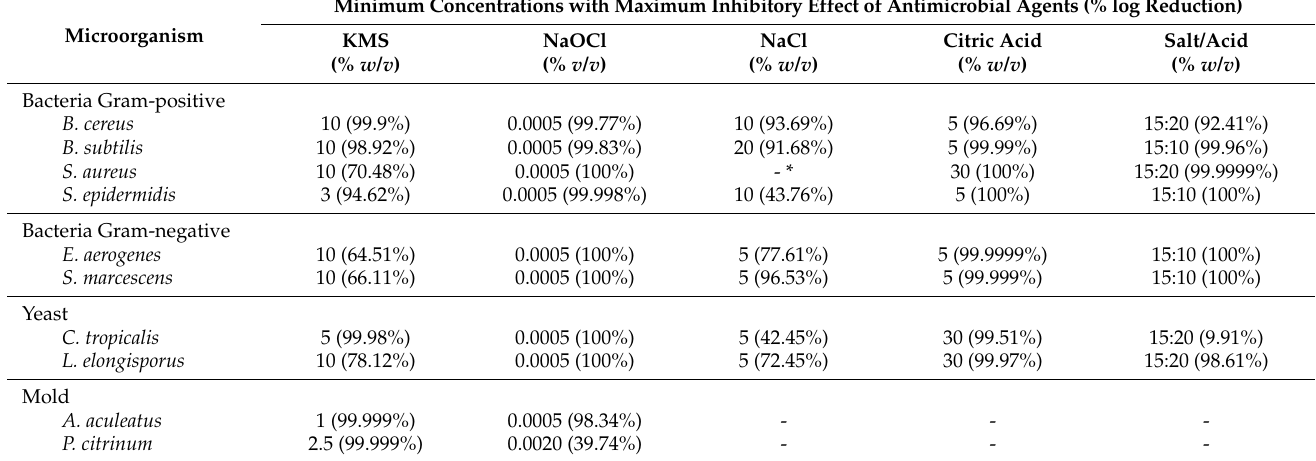
Table 2. Efficacy of antimicrobial agents on B. cereus , B. subtilis , S. aureus , S. epidermidis , E. aerogenes ,